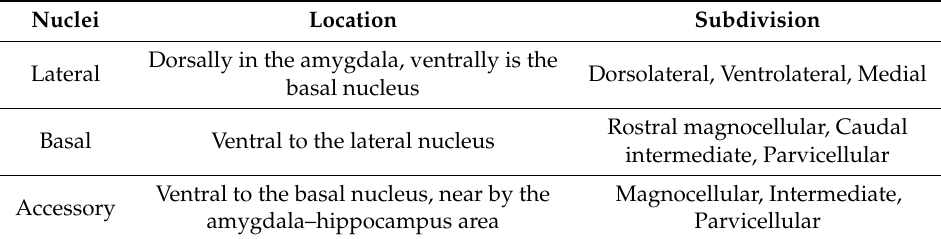
Table 1. Division and subdivision of basolateral amygdala nuclei according to location.